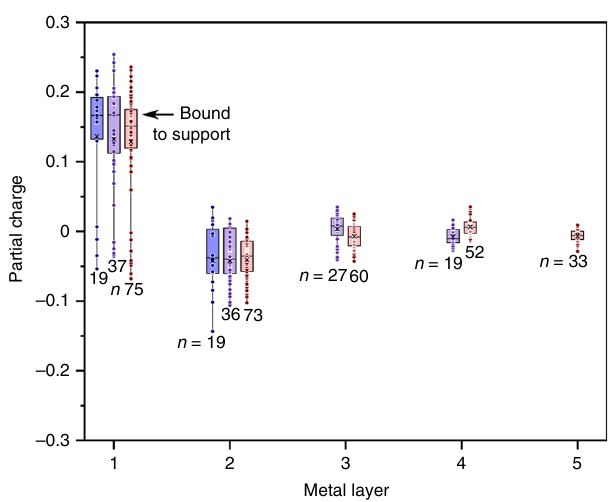
Fig. 7 Partial charge analysis. Partial charges (QUAMBO) of each Pd atom, organized by metal layer for a 38-atom ( blue , 2 layers), 119-atom ( purple , 4 layers), and 293-atom ( red , 5